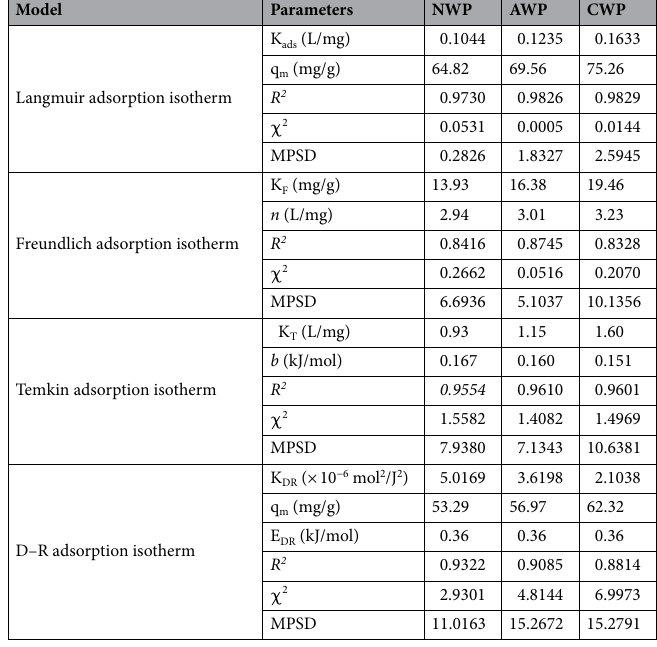
Table 1. Isotherms constants for the adsorption of Cr(VI) on biosorbents.